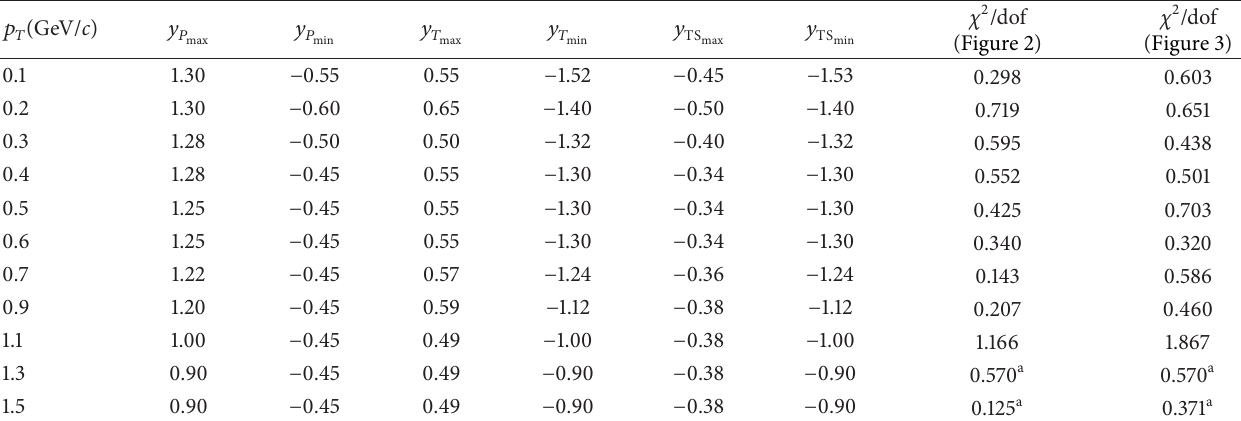
Table 1: Values of the rapidity shifts and 𝜒 2 /dof for the fits in Figures 2 and 3. The relative errors of the rapidity shifts are 6%.